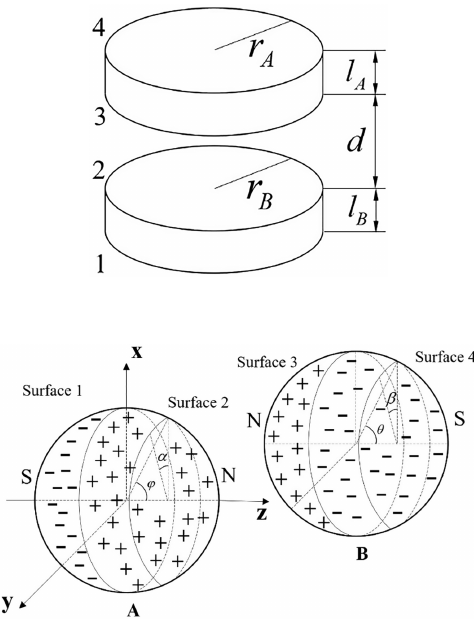
Figure 13. The positions of surface magnetic charges of spherical permanent magnets in coordinate